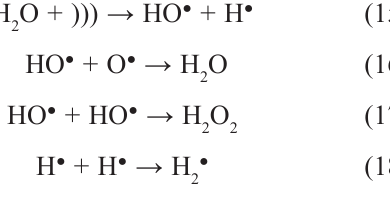
Table 1 – Results of kinetics study of the CWPO/US-Fe